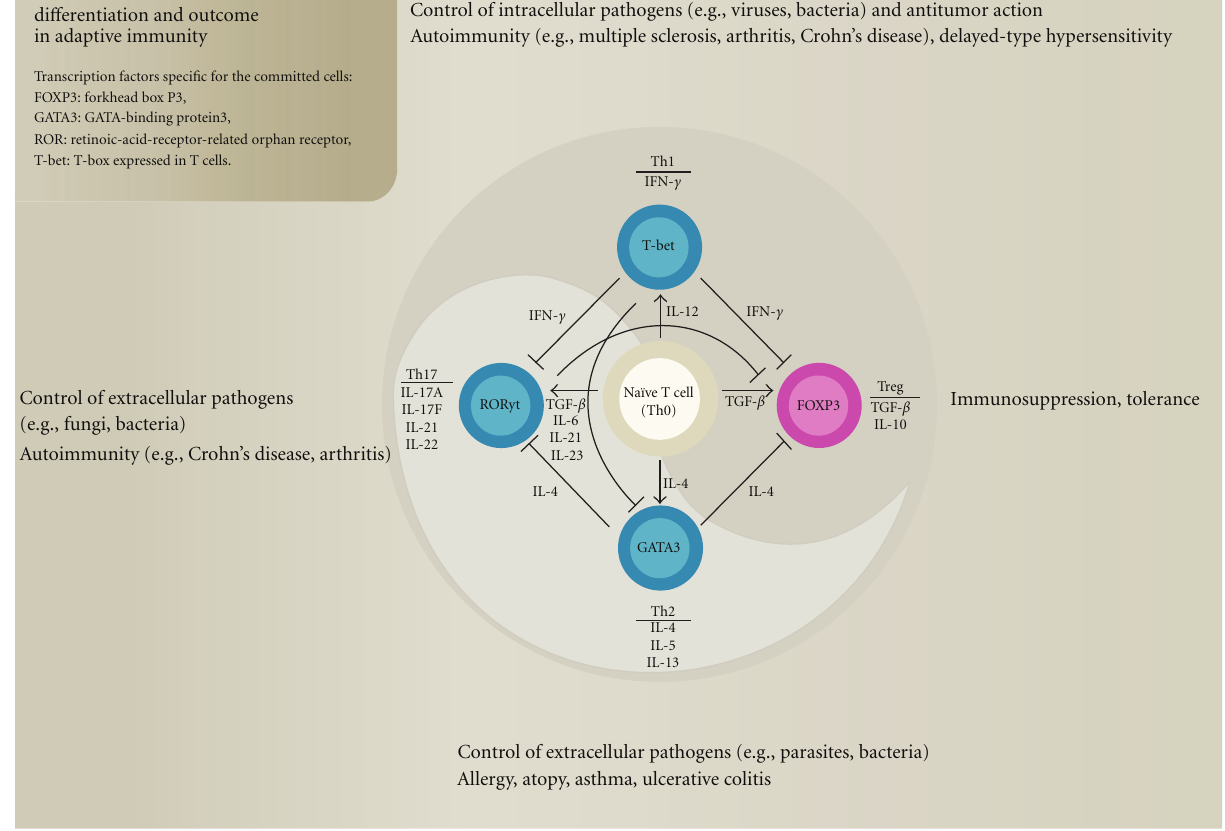
Figure 6: The Ying and Yang of adaptive immunity. There is a balance between the Th responses in such a way that Th1 inhibits Th2, which inhibits Th17 and which again inhibits the Treg response. “Over-shoot” of Th1 and Th17 responses in susceptible individuals can result in autoimmune disorders. The regulation by T reg cells results in immunosuppression and tolerance. The Agaricus mushroom shifts the Th1/Th2 balance towards increased Th1 response, which in addition to intracellular pathogens also fights cancer.